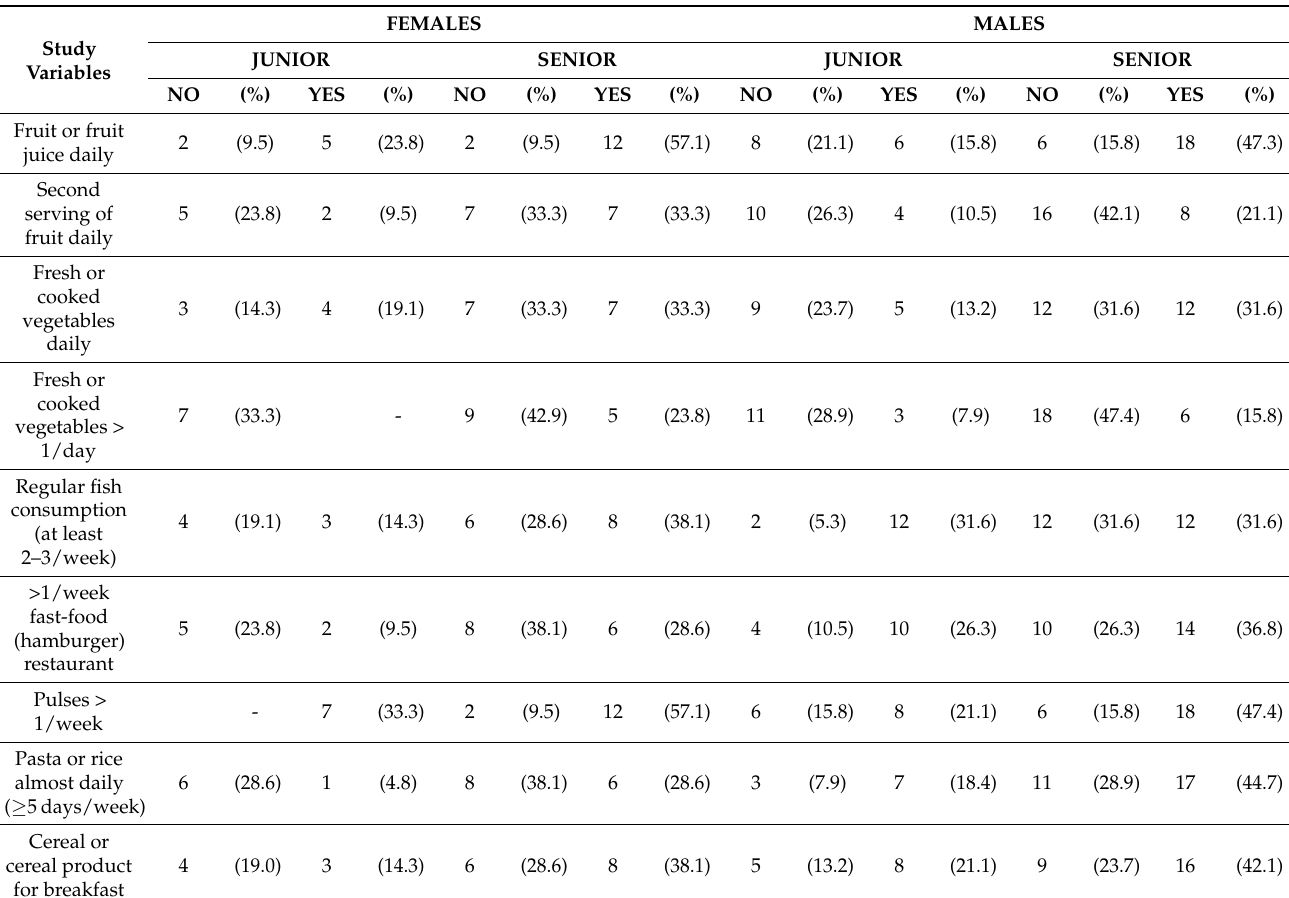
Table 1. Mediterranean diet quality index statistics for total